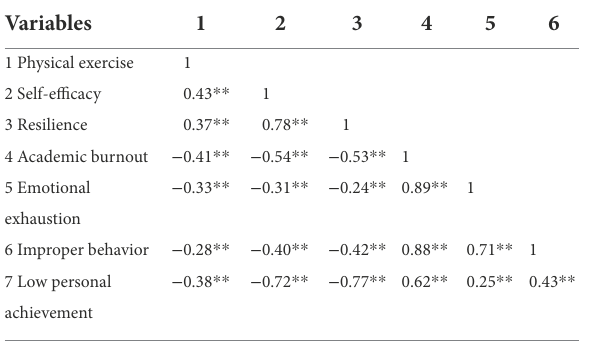
Table 2 Correlation coefficients between the study variables.